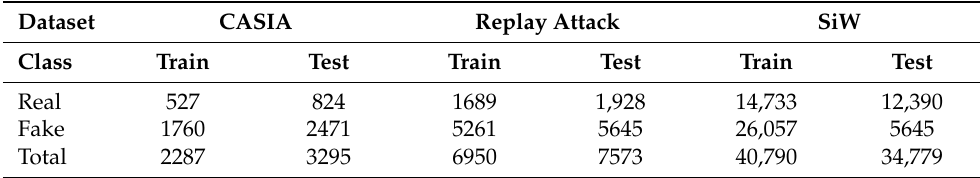
Table 2. Datasets used in experiments and their sample size in train and test